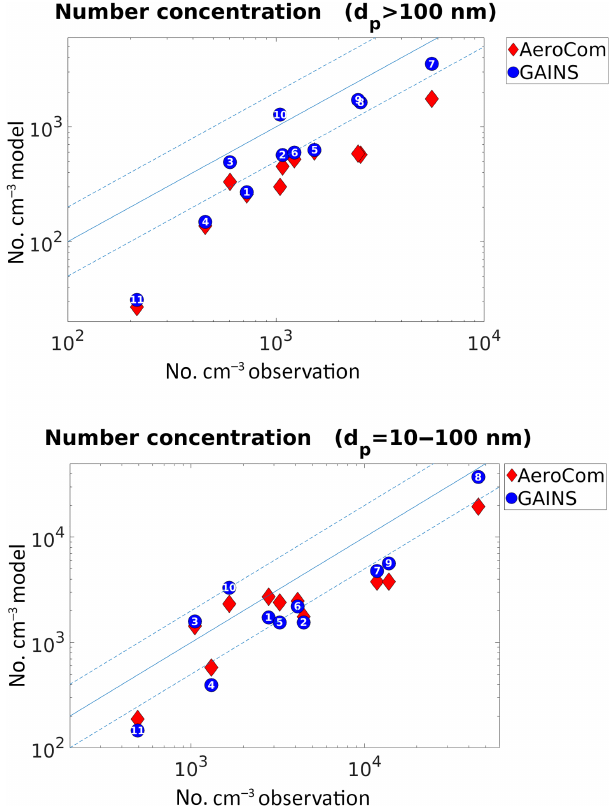
Figure 4. Annually averaged number of particles compared to observational data. Measurement sites: 1: Botsalano; 2: Cabauw 3: Hohenpeißenberg; 4: Hyytiälä; 5: K-Puszta; 6: Melpitz; 7: Nan- jing; 8: Po Valley; 9: São Paulo; 10: Tomsk FNV; 11: Värriö. Both plots include 1:1 and dashed 1 : 2, 2 : 1